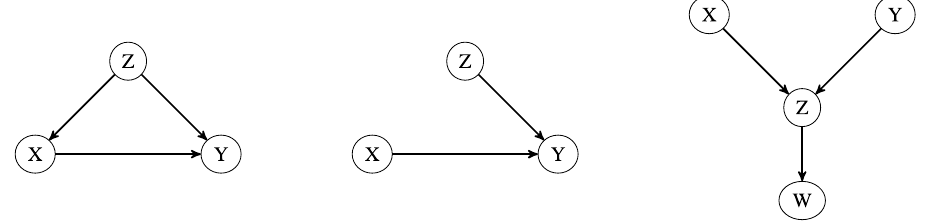
Figure 2. Left: A DAG (G) representing relationship among random variables X , Y , Z ; middle: a mutilated network ( G m ) representing intervention on X ; yight: Y-structure from four variables X , Y , Z , W